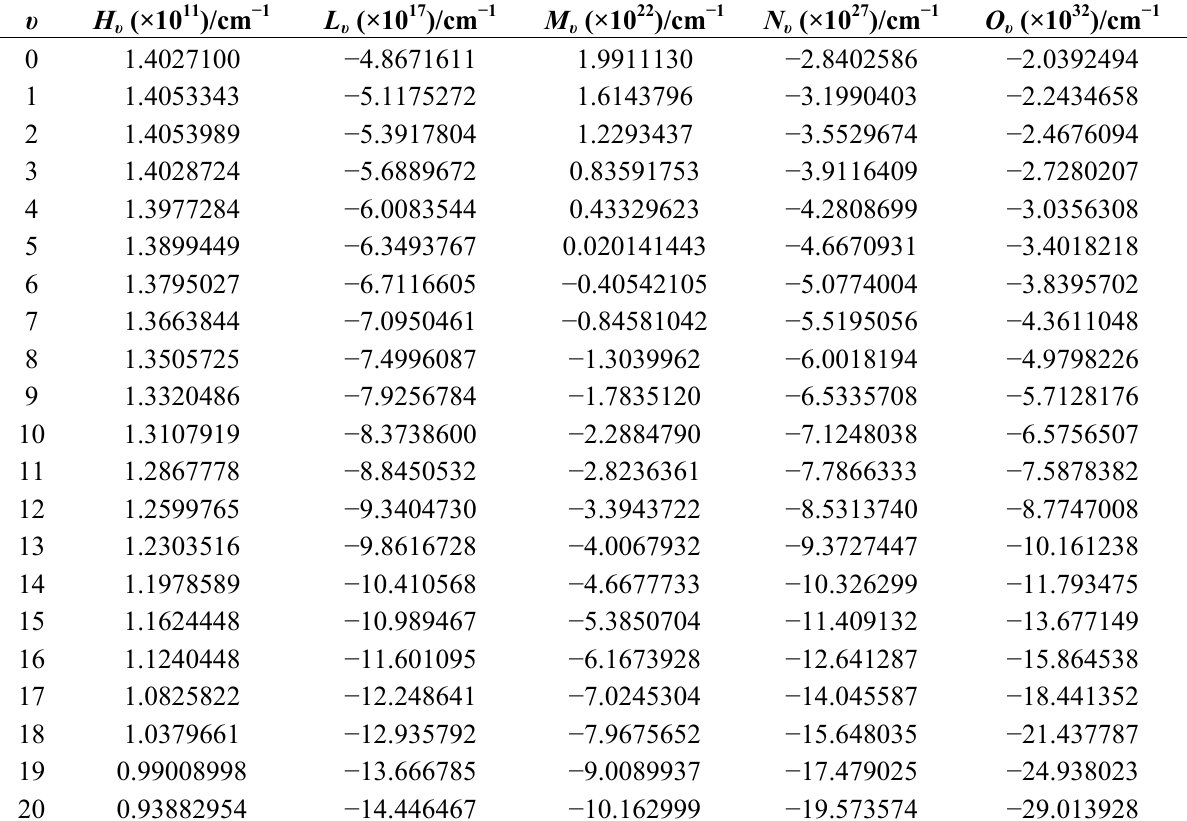
Table 5. The centrifugal distortion constants for the BeF(X 2 Σ + ) radical when J = 0.